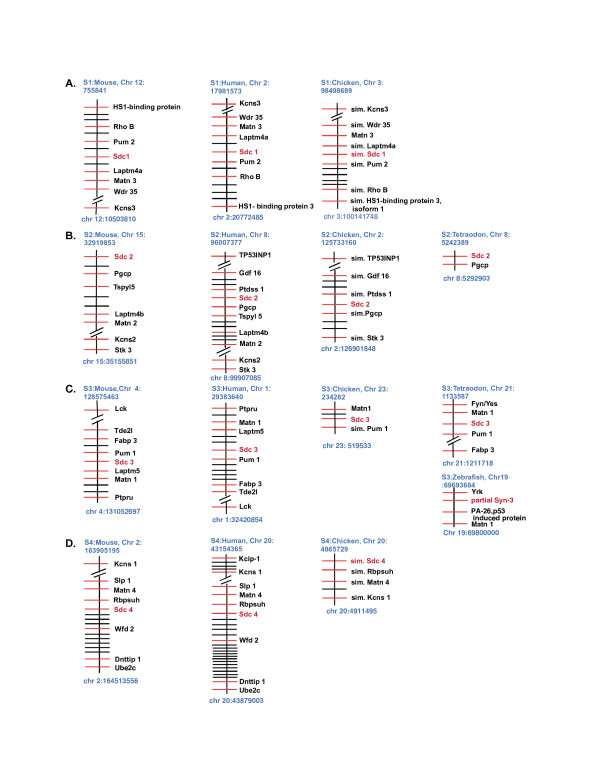
Conservation of synteny between vertebrate syndecan genes. The genomic contexts of: (A), syndecan-1 genes; (B), syndecan-2 genes; (C), syndecan-3 genes and (D), syndecan-4 genes, were analysed for conservation of neighboring genes in the human, mouse, chicken, T. nigroviridis and D. rerio genomes. Each diagram represents the order of genes along a portion of the indicated chromosomes. Each horizontal line represents a gene: red lines represent genes that are syntenic and black lines represent non-conserved intervening genes. The numbers indicate the exact location in nucleotides of each region on its respective chromosome in each species. HUGO gene names are given, and the syndecan genes are indicated in red.